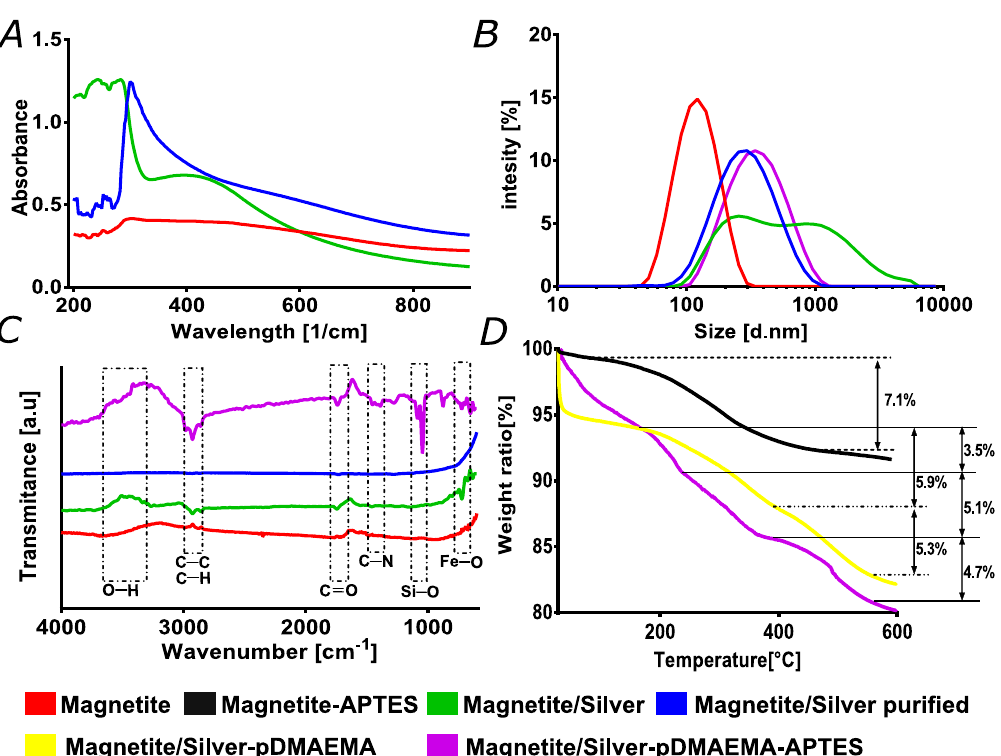
Figure 3. Characterization and purification process of magnetite / silver without purification (green). ( A ) UV-Visible spectra were collected to verify the silver coverage on magnetite nanoparticles, plus the e ff ect of purification toward sample homogeneity. ( B ) Nanoparticles size distribution via dynamic light scattering. The data were useful to verify the homogeneity of the sample. ( C ) Fourier transform infrared spectroscopy (FTIR) spectra were used to evaluate the e ff ectiveness of purification and cleaning of the nanoparticles and verify the presence of both chemistries on the magnetite / silver-pDMAEMA-APTES nanoparticles. Highlighted regions corresponding to pDMAEMA are C = O, C-C, and C-H bonds. Simultaneously, the silanization is corroborated by Si-O and C-N bonds, which are related ( D ) Thermogravimetric analyses (TGA) were also conducted to verify the e ff ectiveness of conjugation